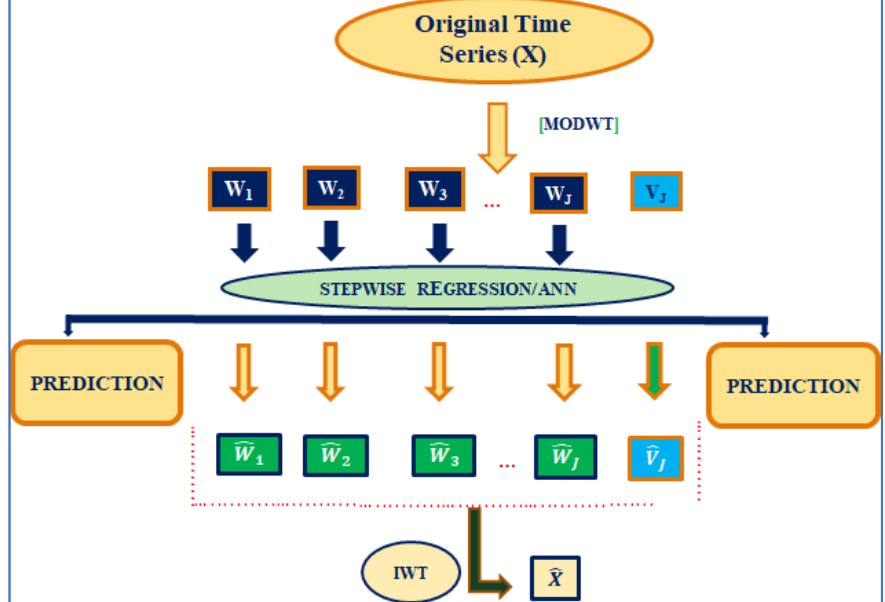
Figure 3. Schematic representation of W–LR and W–ANN algorithm (MODWT: Maximal overlap discrete wavelet transform; IWT: Inverse wavelet transform).